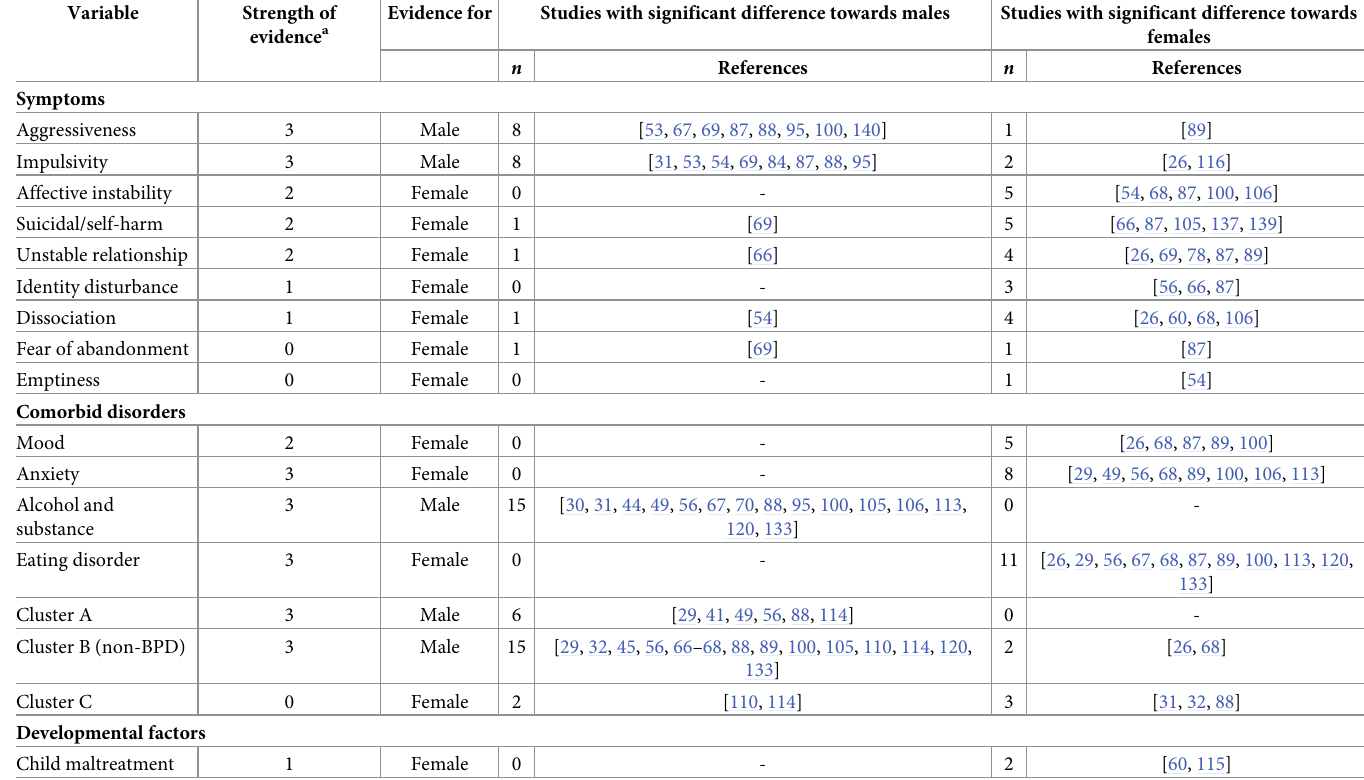
Table 1. Mixed-sex comparisons for BPD symptoms, comorbid disorders, and developmental factors in BPD populations ( n = 37).